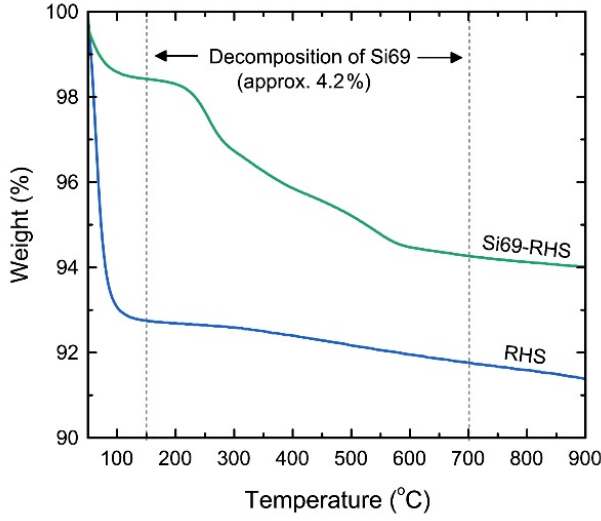
Figure 5. Comparative TGA curves of RHS and Si69-RHS under N 2 flow.